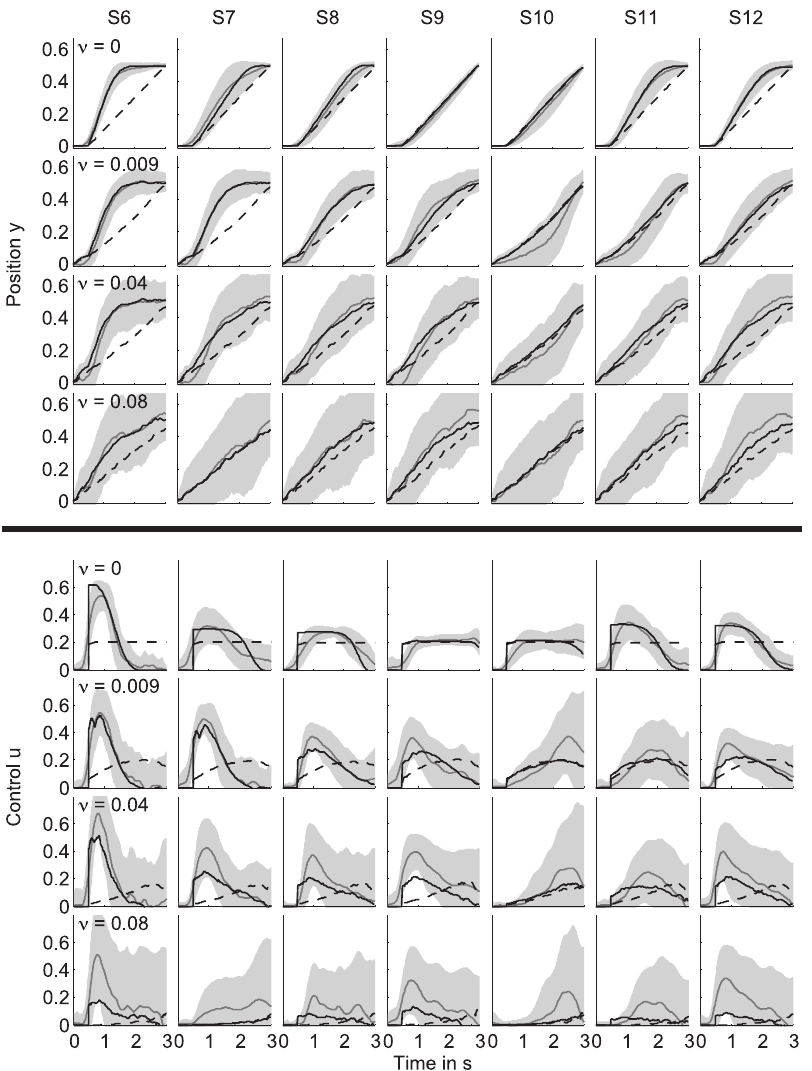
Figure 4. Behavior and model predictions for the two-target task. See figure 2 for details.